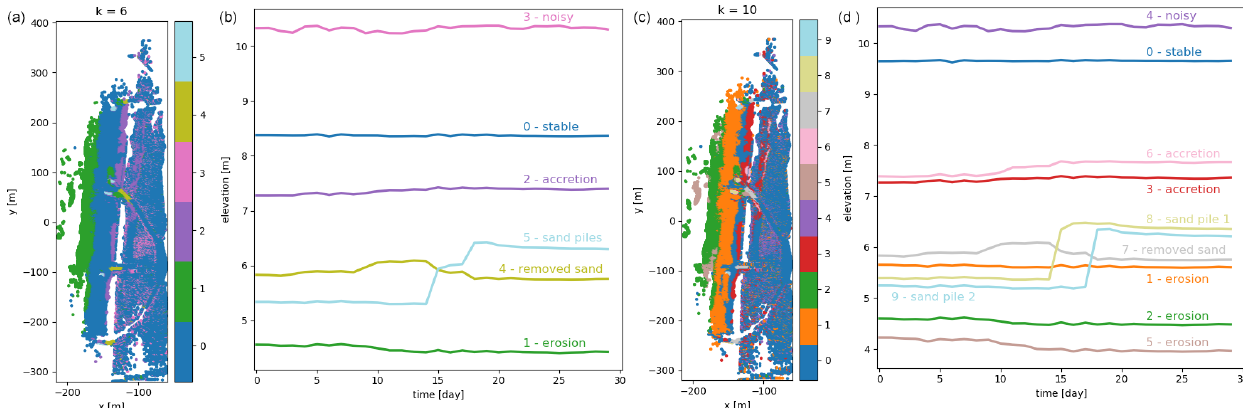
Figure 8. (a, c) Overview of the entire observation area divided into clusters using agglomerative clustering with k = 6 (a) and k = 10 (c) . (b, d) Corresponding cluster centroids for each of the clusters shown in panels (a) and (c) , respectively. The clusters are similar to the ones found with k -means clustering.